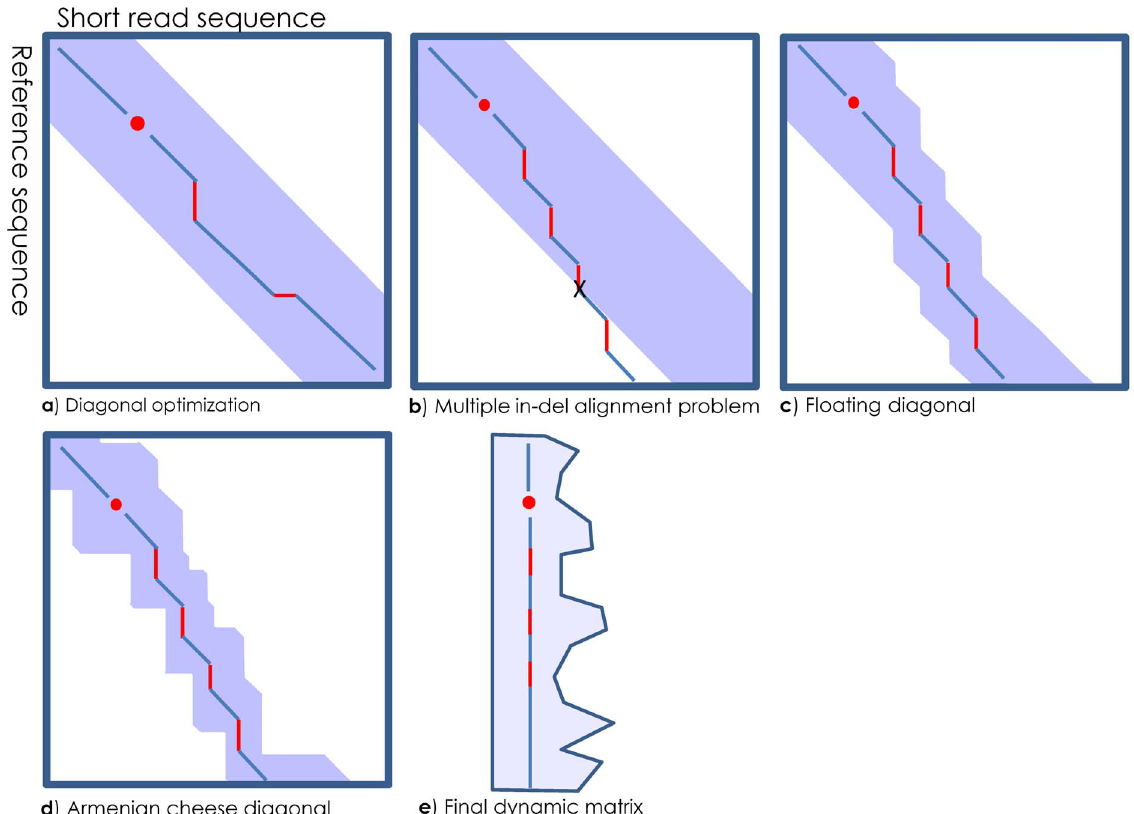
Figure 4. Dynamic programing matrix linearization schema. HIVE-hexagon implements a floating diagonal approach where the diagonal of the computation is maintained along the two sides of the current highest scoring path of the matrix. ( a ) We assume the optimal alignment will be along the diagonal. ( b ) Multiple insertions or deletions can result in the optimal path traversing outside the defined diagonal belt. ( c ) By defining a constant width to the diagonal and pre-computing cell scores line by line, the limits of the remaining diagonal matrix can float along with the likely optimal scoring path. ( d ) Furthermore, pre-computation of cells in the diagonal line by line allows the exclusion of regions which cannot possibly contain the highest scoring path. ( e ) The resulting minimized, dynamic diagonal matrix is linearized to further simplify the process and minimize the memory footprint required.